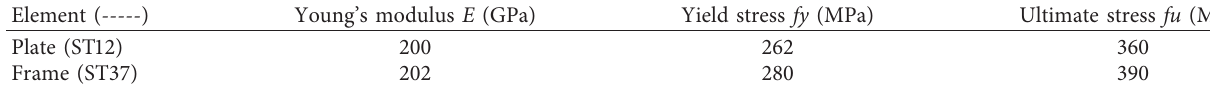
Table 1: Material mechanical properties.